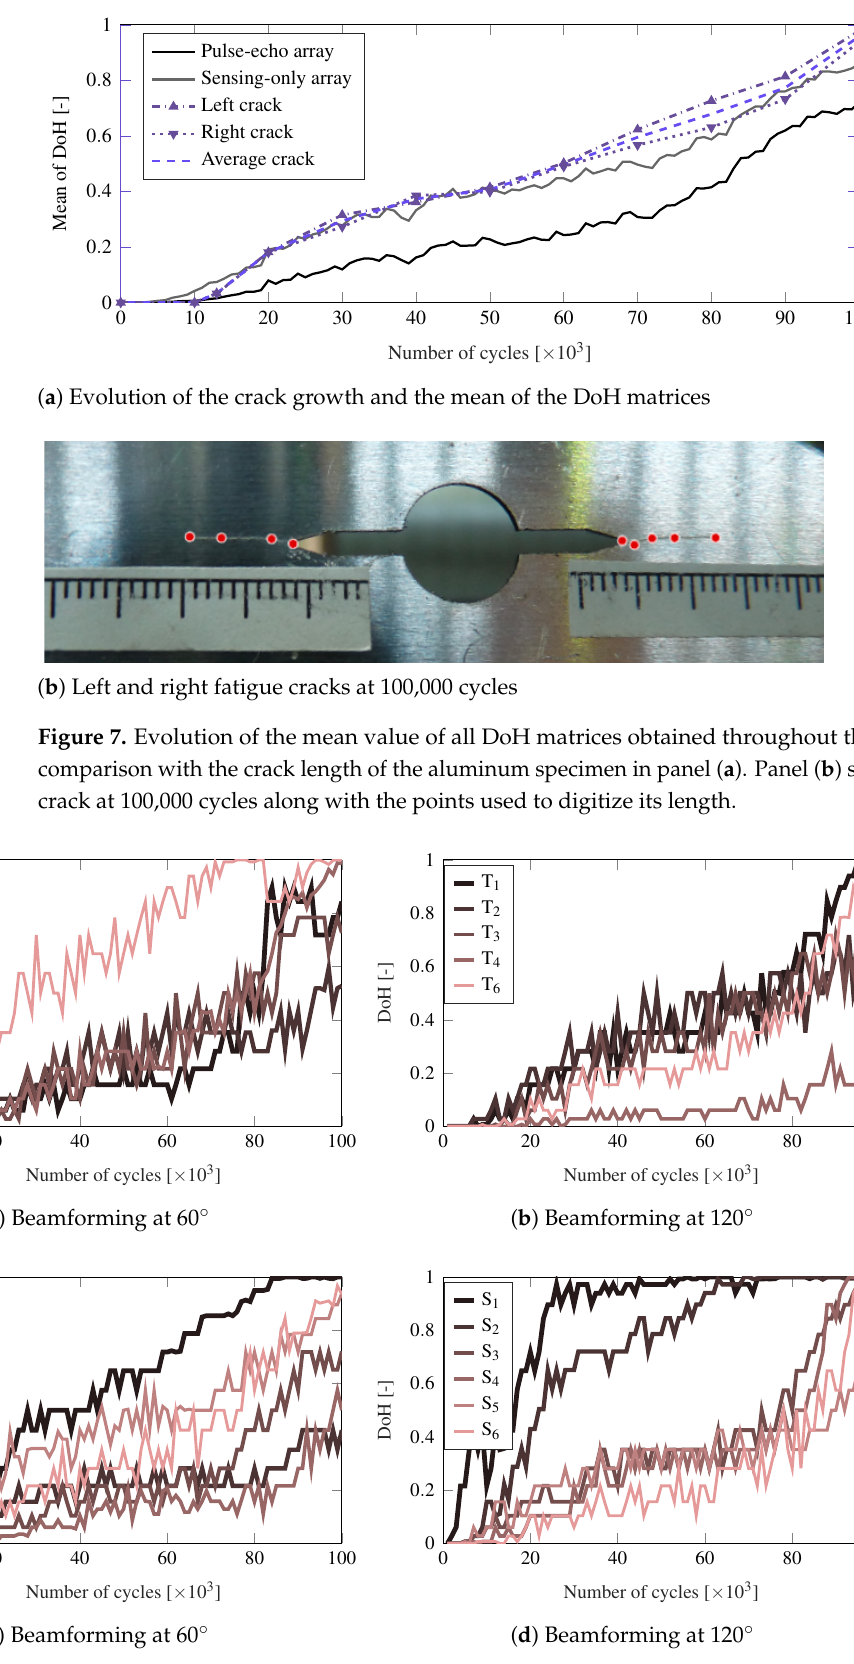
Figure 8. Evolution of M j for the PWAS of the arrays in pulse-echo (panels ( a , b )) and pitch-catch (panels ( c , d )) modes at two particular